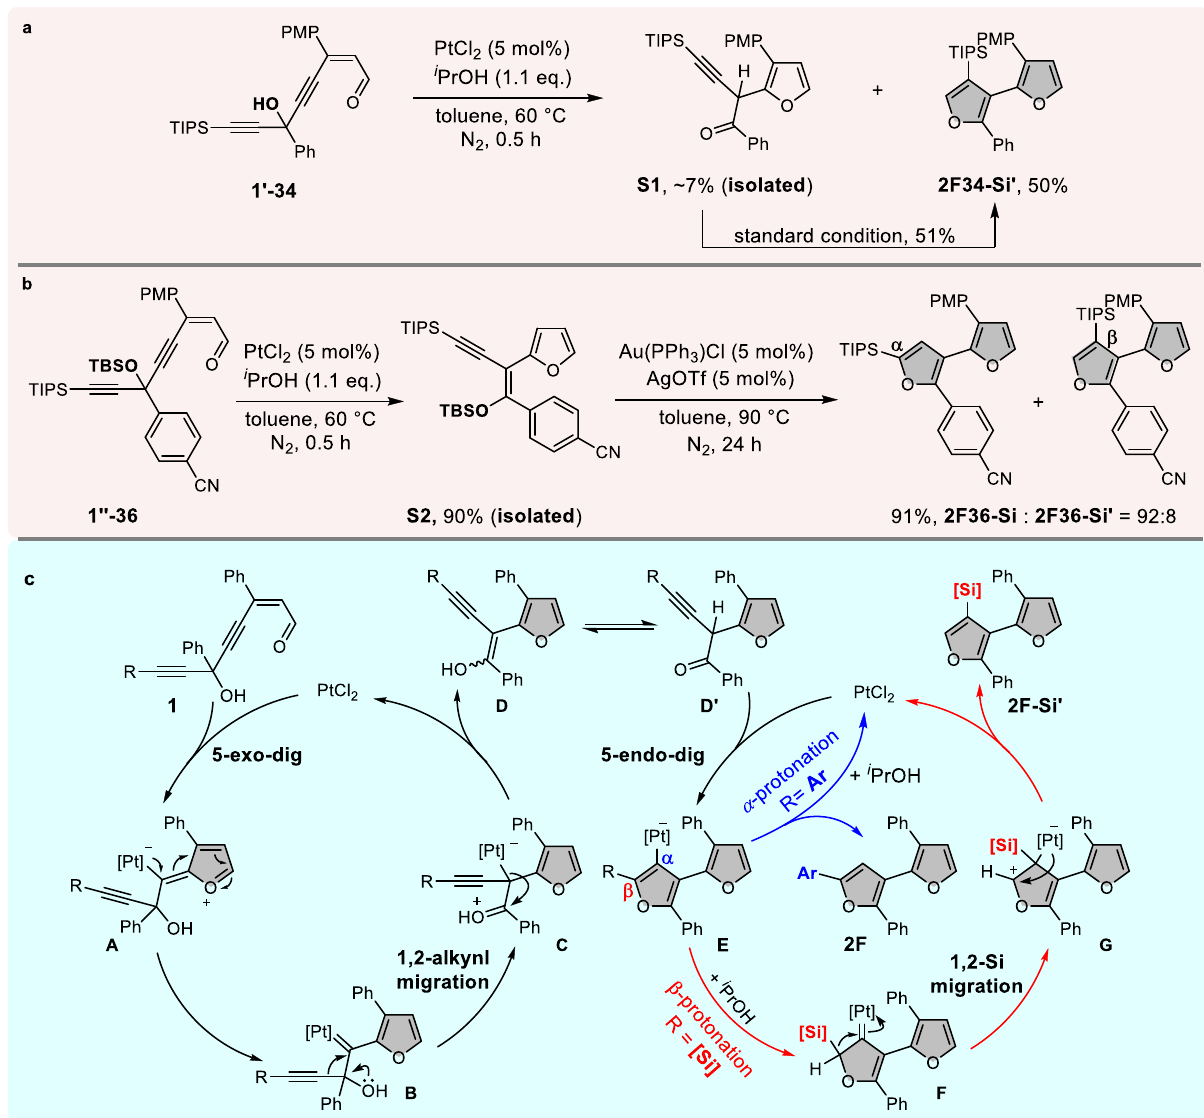
Fig. 3 Preliminary mechanism studies and possible mechanism. a , b Control experiments. c Proposed reaction pathway. PMP = p -MeO-C 6 H 4